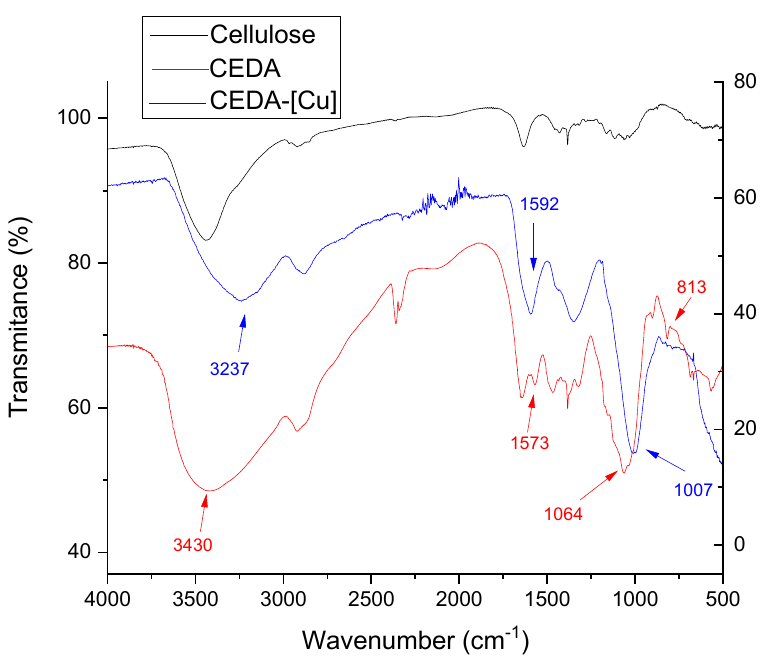
Figure 2. FTIR spectra of cellulose, CEDA, and CEDA-[Cu].